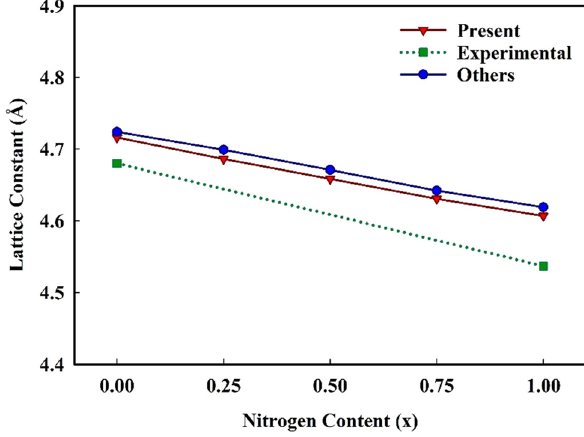
Figure 1: lattice constant of ZrC ( 1 − x ) N ( x ) as a function of nitrogen content ( x ) .